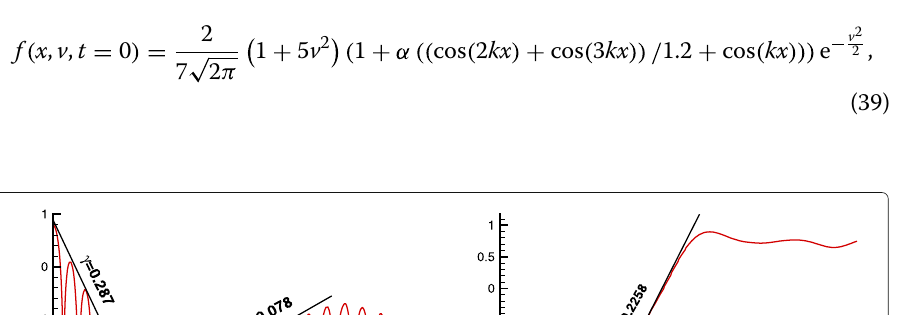
the L 2 norm electric field is plotted in Fig. 3. It can be observed that the decay rates and oscillating frequencies 1.16, 1.29 agree well with theoretical data. Once a larger perturbation with 0.5 and k 0.5 is applied, the linear theory breaks down, and the nonlinear phenomenon occurs. The evolution of the electric energy calculated by the UGKWP method is shown in Fig. 4a. The linear decay rate of electric energy is approximately equal to 1 0.287, which agrees well with the values obtained by Heath et al. [41]. The growth rate predicted by the UGKWP method is approximately 2 0.078, which is between the values of 0.0815 computed by Rossmanith and Seal and 0.0746 by Heath et al. [42].